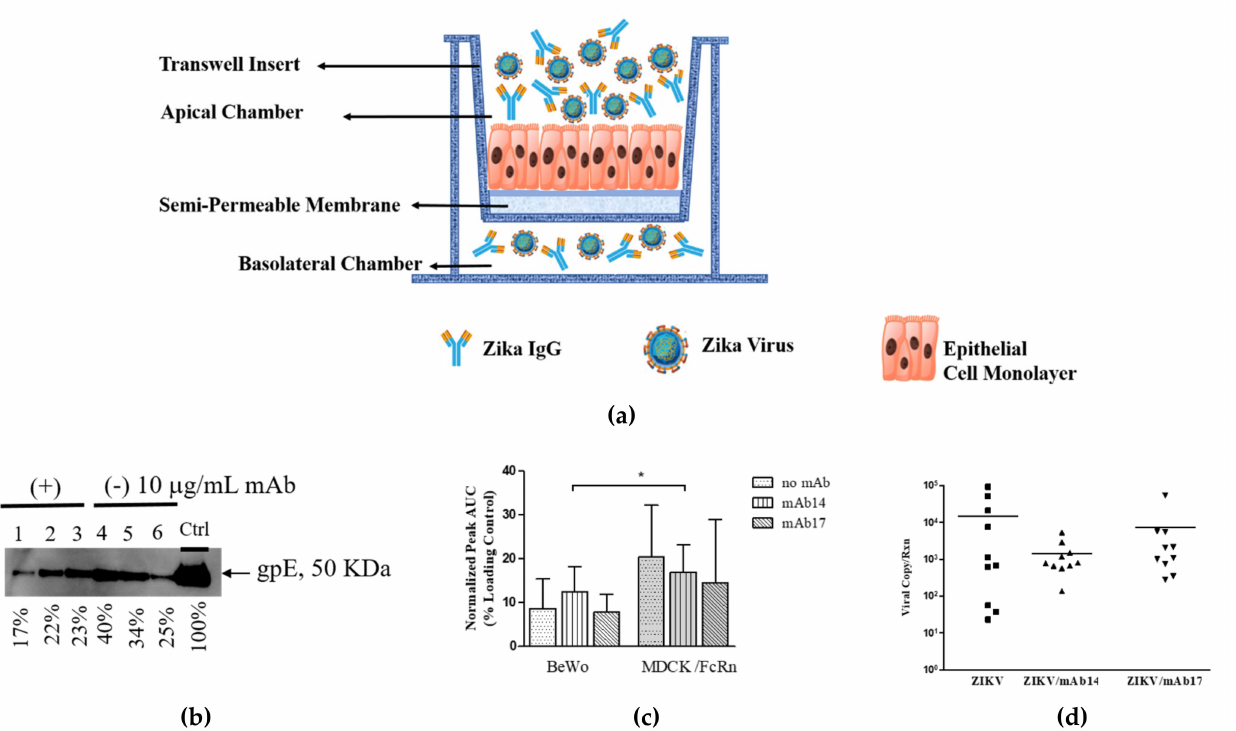
Figure 1. Transcytosis of Zika virus envelope glycoprotein (gpE) or intact Zika virus alone or as part of immune complexes (IC) in epithelial cell monolayers. ( a ) Schematic of the experimental set up. MDCK cells that overexpress human FcRn and BeWo cells were grown on semipermeable membranes; IC were added on the apical chamber. ( b ) Typical Western blot analysis of the contents of the basolateral chamber of transcytosis experiments with MDCK/FcRn or BeWo cells, blotting for gpE. Shown are three replicates for each IC performed with 10:100 (lanes 1–3) and 0:100 (lanes 4–6) µ g/mL IgG:gpE mixtures; experiment was repeated to confirm the results. Signal intensities for each band were computed using densitometry (ImageJ) and are presented as a percentage of the positive control. Uncropped image of the Western blot is shown in Supplemental Figure S1. ( c ) Quantification of band intensity from western blots such as the one shown in ( b ) using densitometry (ImageJ). Each column represents the average signal from five or six replicates; error bars represent standard deviation. Two-way ANOVA was used to compare MDCK/FcRn (shaded bars) and BeWo (clear bars) cells (row factor); * p < 0.05. ( d ) Transcytosis of intact Zika virus in MDCK/FcRn and BeWo cell monolayers occurs for the virus alone or in the presence of mAb. Experiments were performed in triplicates or quadruplicates and repeated three times. Shown are the repeats from experiments performed in MDCK/FcRn cells. Similar high variability but lower group averages was seen in BeWo